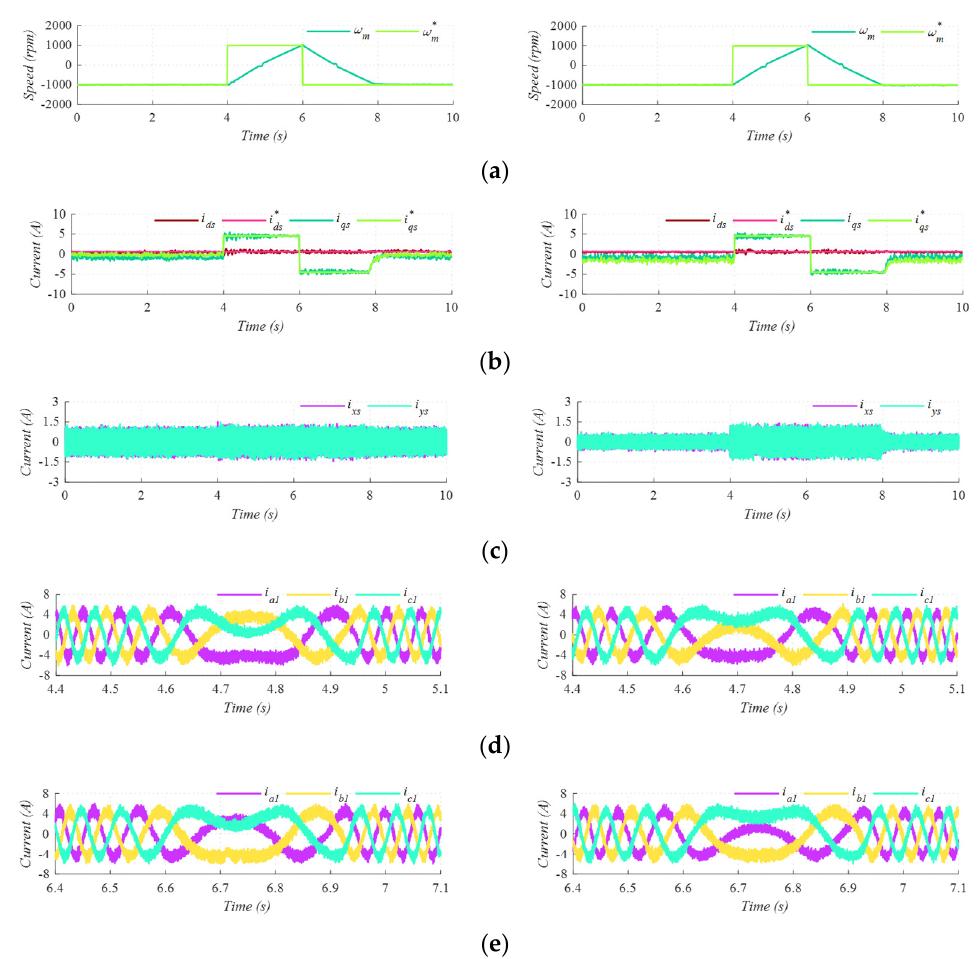
Figure 11. Double reversal-speed test for PULLA-MPC. From top to bottom: ( a ) motor speed, ( b ) 𝑑 - 𝑞 currents, ( c ) 𝑥 - 𝑦 currents, ( d ) zoom 1 of set 1 of phase currents and ( e ) zoom 2 of set 1 of phase currents.